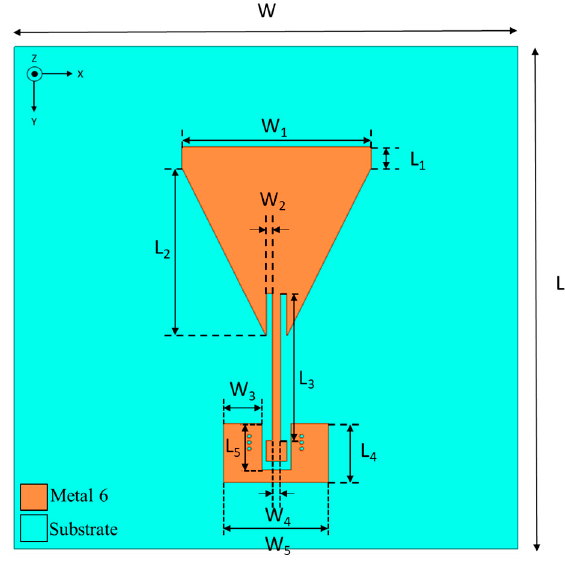
Figure 4. The geometry of the proposed antenna-on-chip. Table 1. Detailed value of the proposed antenna.